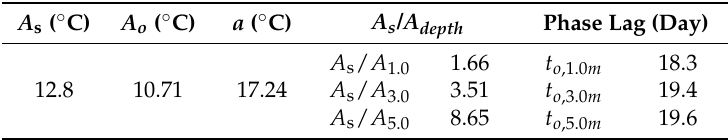
Table 5. Coefficients for estimating ground temperature in Nagasaki,